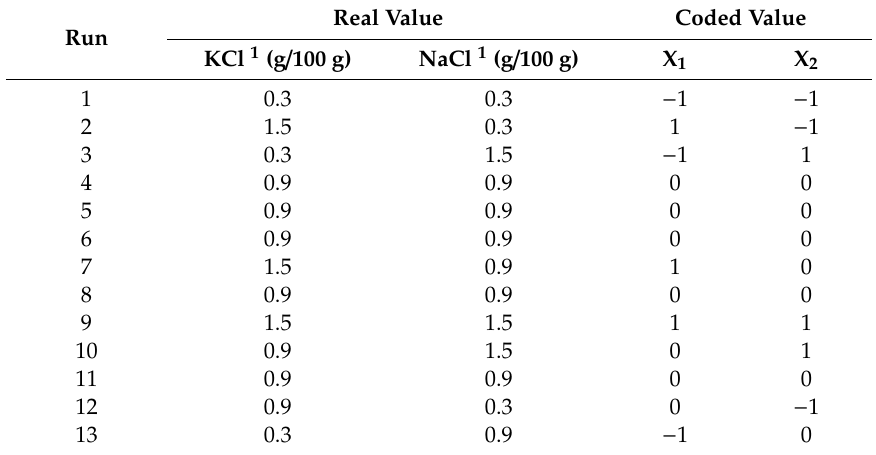
Table 1. Real and coded values of independent variables used in the experimental design. Real Value Coded Run